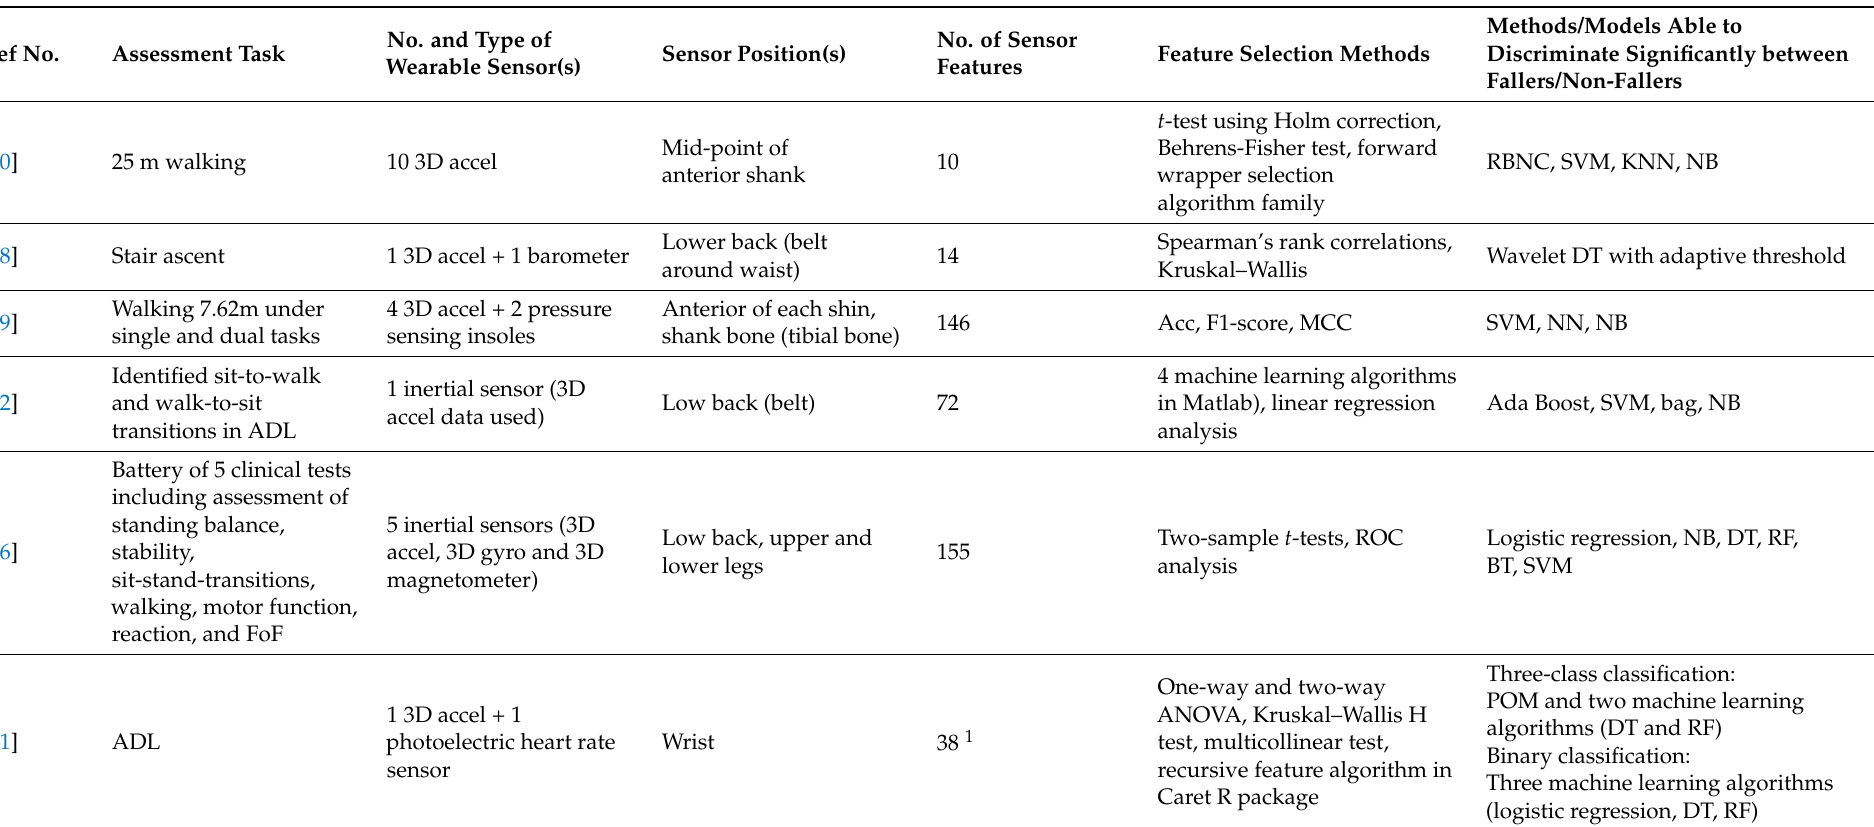
Table 6. Characteristics of SFRA methods using classification methods/models with machine learning algorithms. F1-score = harmonic mean of precision and Sens, MCC = Matthew’s Correlation Coefficient, POM = Proportional odds